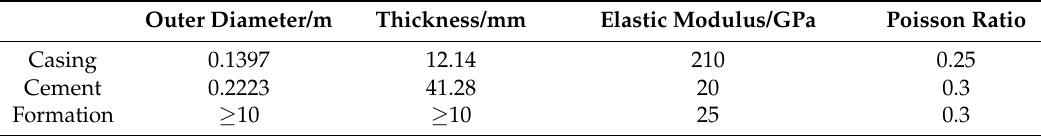
Figure 6. The variations of 𝑆 (cid:2869)(cid:4593) and 𝑆 (cid:2870)(cid:4593) with the change of crustal stress and casing internal pressure. Table 1. Model parameters for casing, cement sheath and